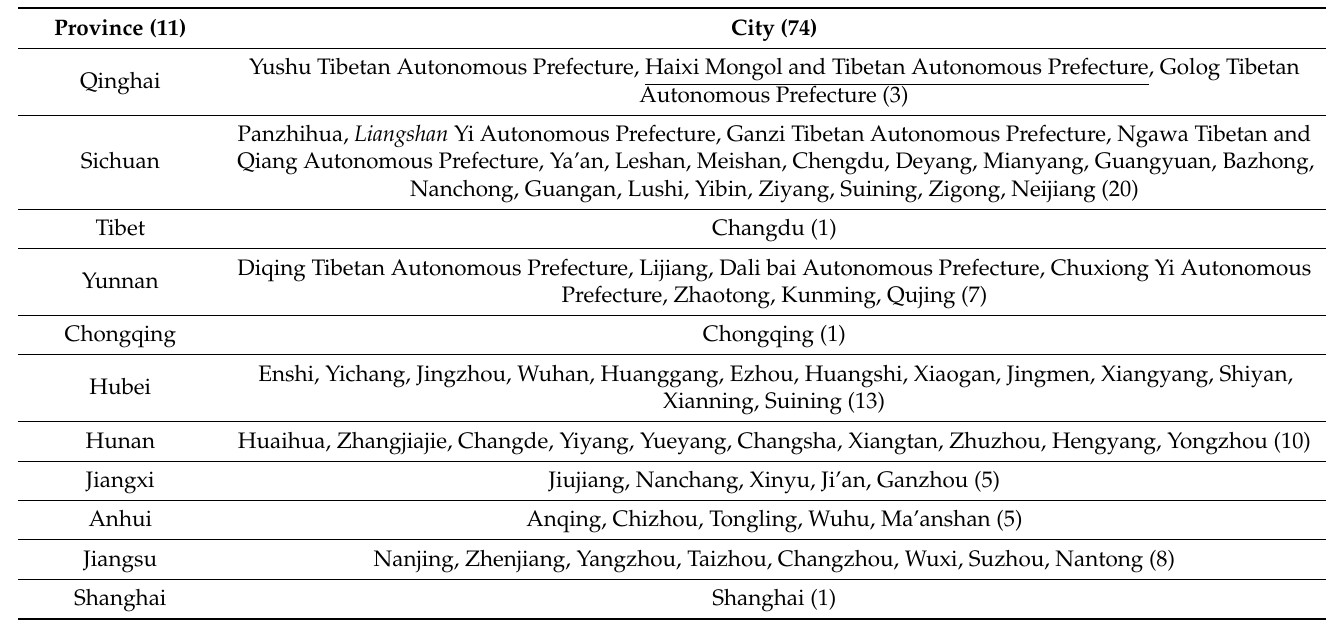
Table 1. Division of administrative districts in Yangtze River (main stream).